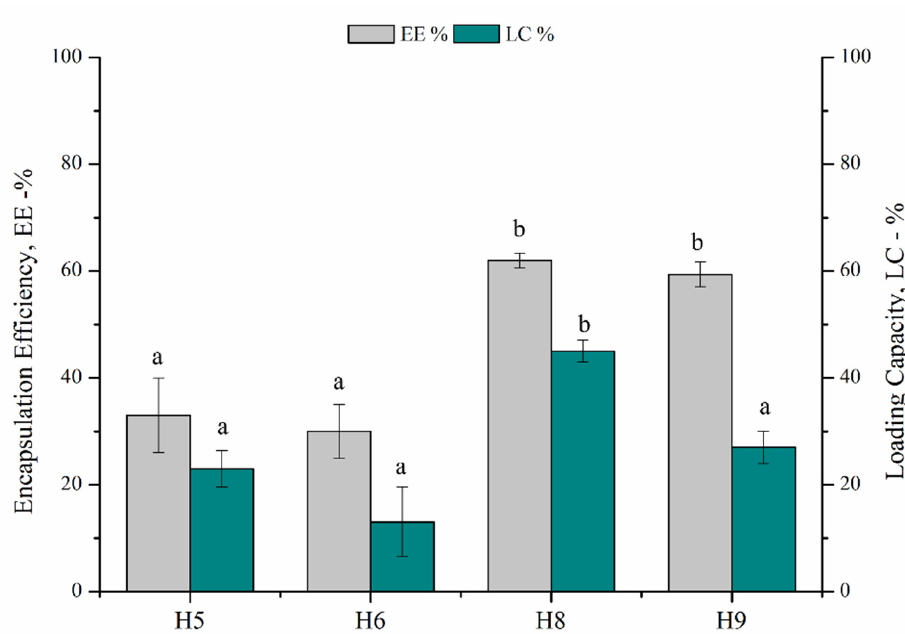
Figure 2. Effect of PHB-HHx polymer concentration and mg EO /mg Polymer ratio ( w/w ) on Encapsulation efficiency, EE%, and Loading capacity, LC%. H5, H6, H8 and H9 correspond to samples reported in Table 2 (means that do not share a letter are significantly different).